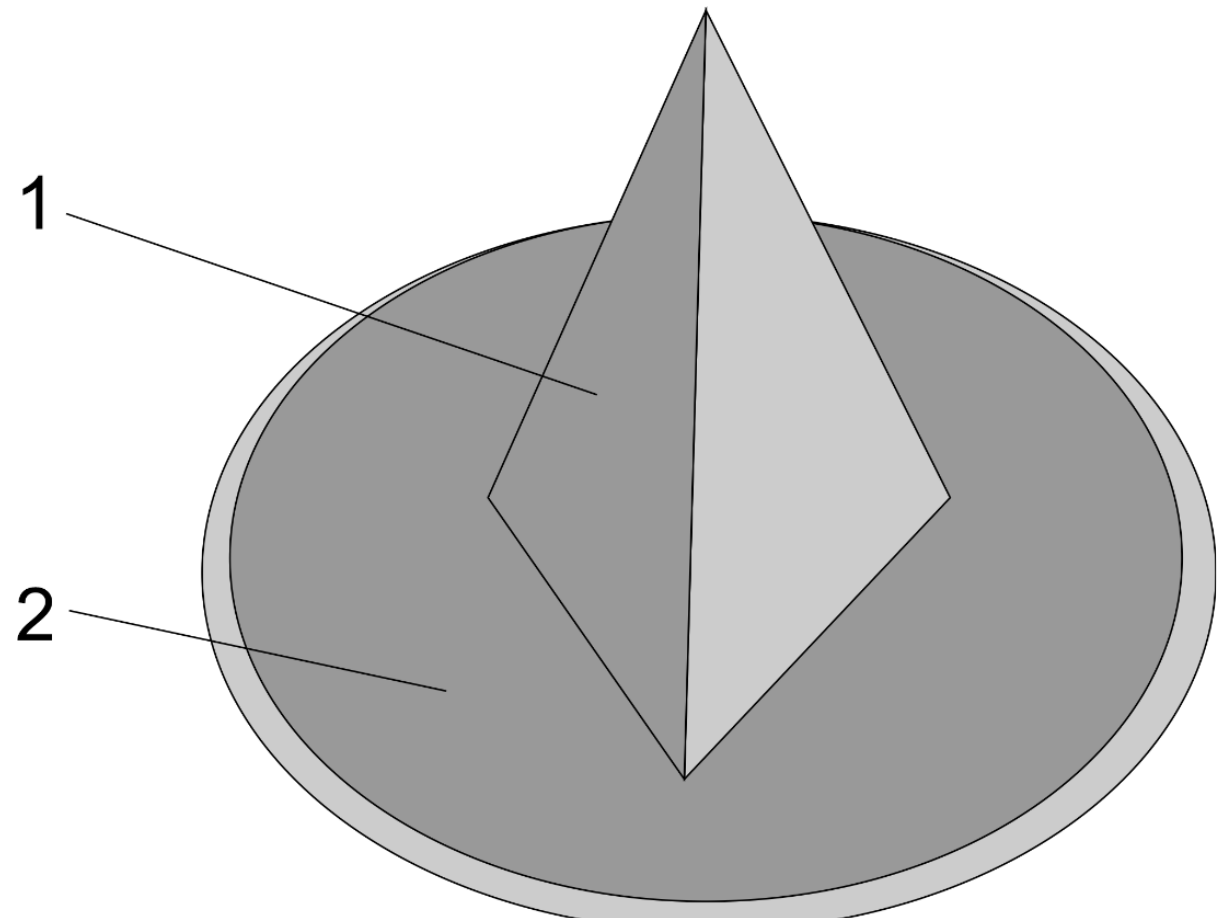
Figure 6. Three-dimensional representation of the temporal bone according to the geometric model for an adult: 1—right pyramid with a triangular base; 2—spherical cap.